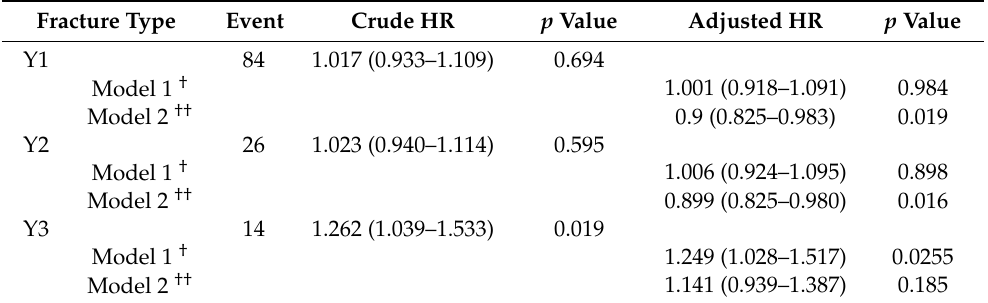
Table 3. Multivariate COX regression analysis of all-site fractures, repeated fractures and osteoporotic fractures among PWH and the matched control group.